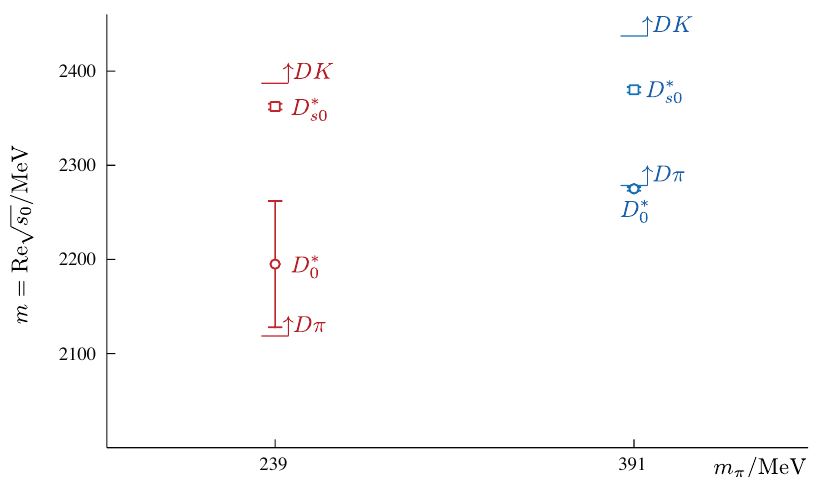
Figure 13. A summary of the real parts of the pole positions found in this analysis and ref. [26] in S -wave Dπ scattering, and ref. [29] in S -wave DK scattering. The D ∗ this study lies on the unphysical sheet with a large width. The other 3 poles are bound